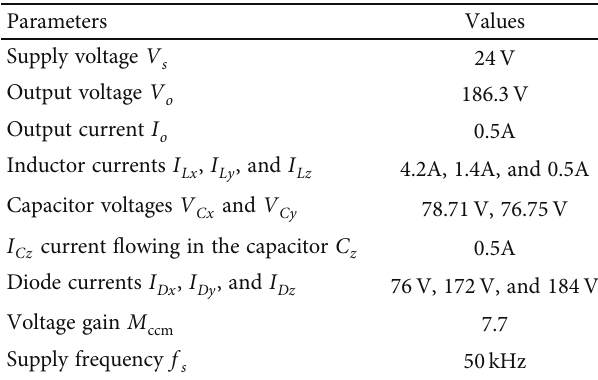
I Cz and (b) voltage across Table 5: Evaluation of the simulation results of the